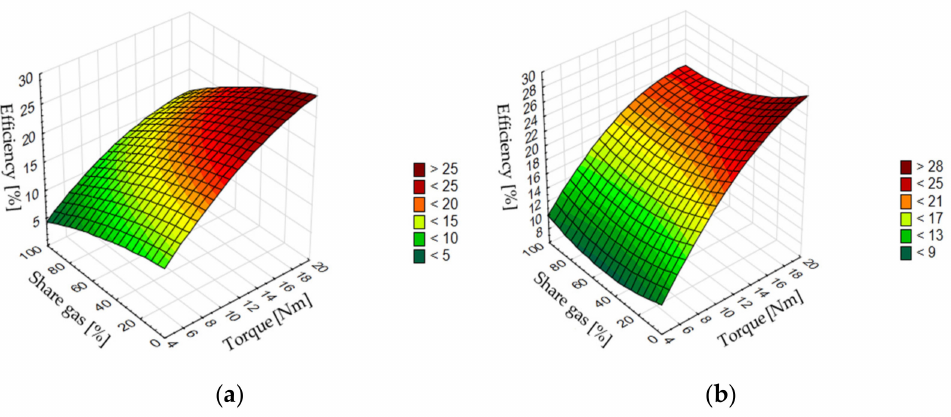
Figure 13. Efficiency of the cogeneration unit for the mixtures: ( a ) DF + BG and ( b ) RME +